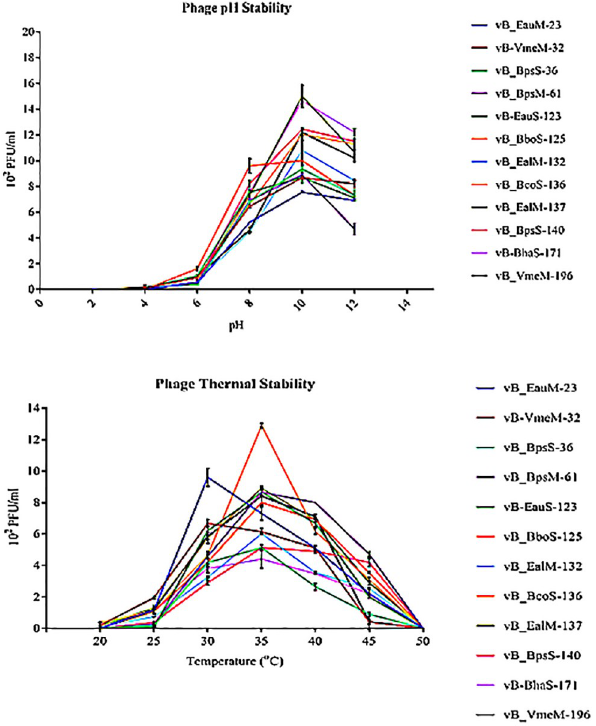
Fig 2. Thermal and pH stability experiments. Infection capability of the phages was highest at 30–35˚C and more infective in alkali condition of between pH 10–12.